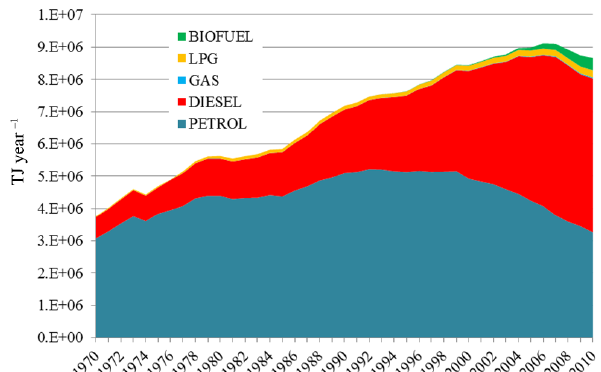
Figure 6. Change between 1970 and 2010 of energy content of ma- jor fuels (TJyr − 1 ) used by EU27 passenger cars. Note the large shift from petrol to